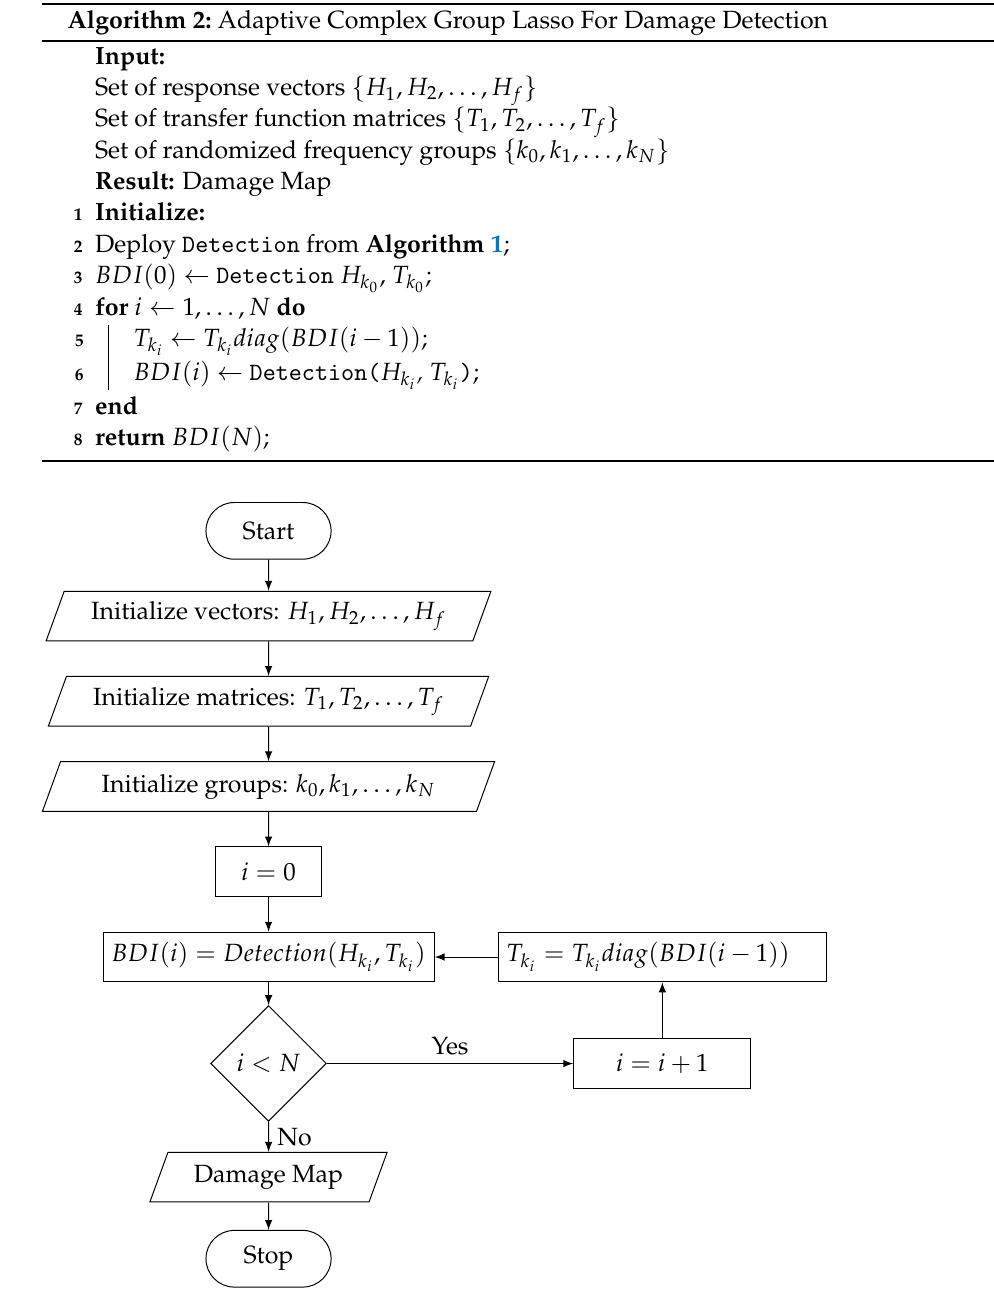
Figure 1. Flowchart of the Adaptive Complex Group Lasso for Damage Detection. Using Algorithm 2, the prediction made for the last group of frequencies is used to plot a damage map on the structure, across the respective imaging points’ coordinates. Peaks on the map again indicate points of